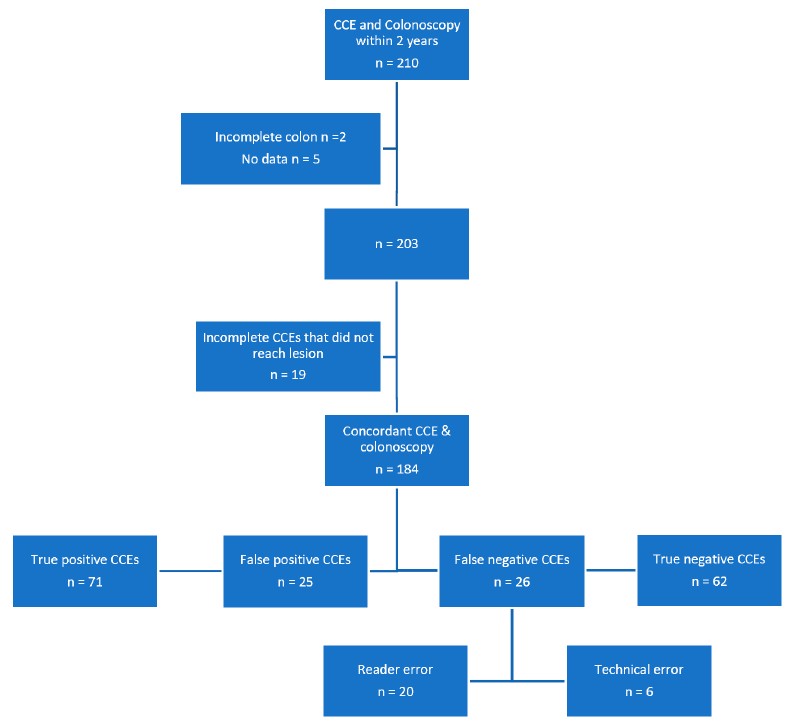
Figure 2. Study Figure 2. Study population.